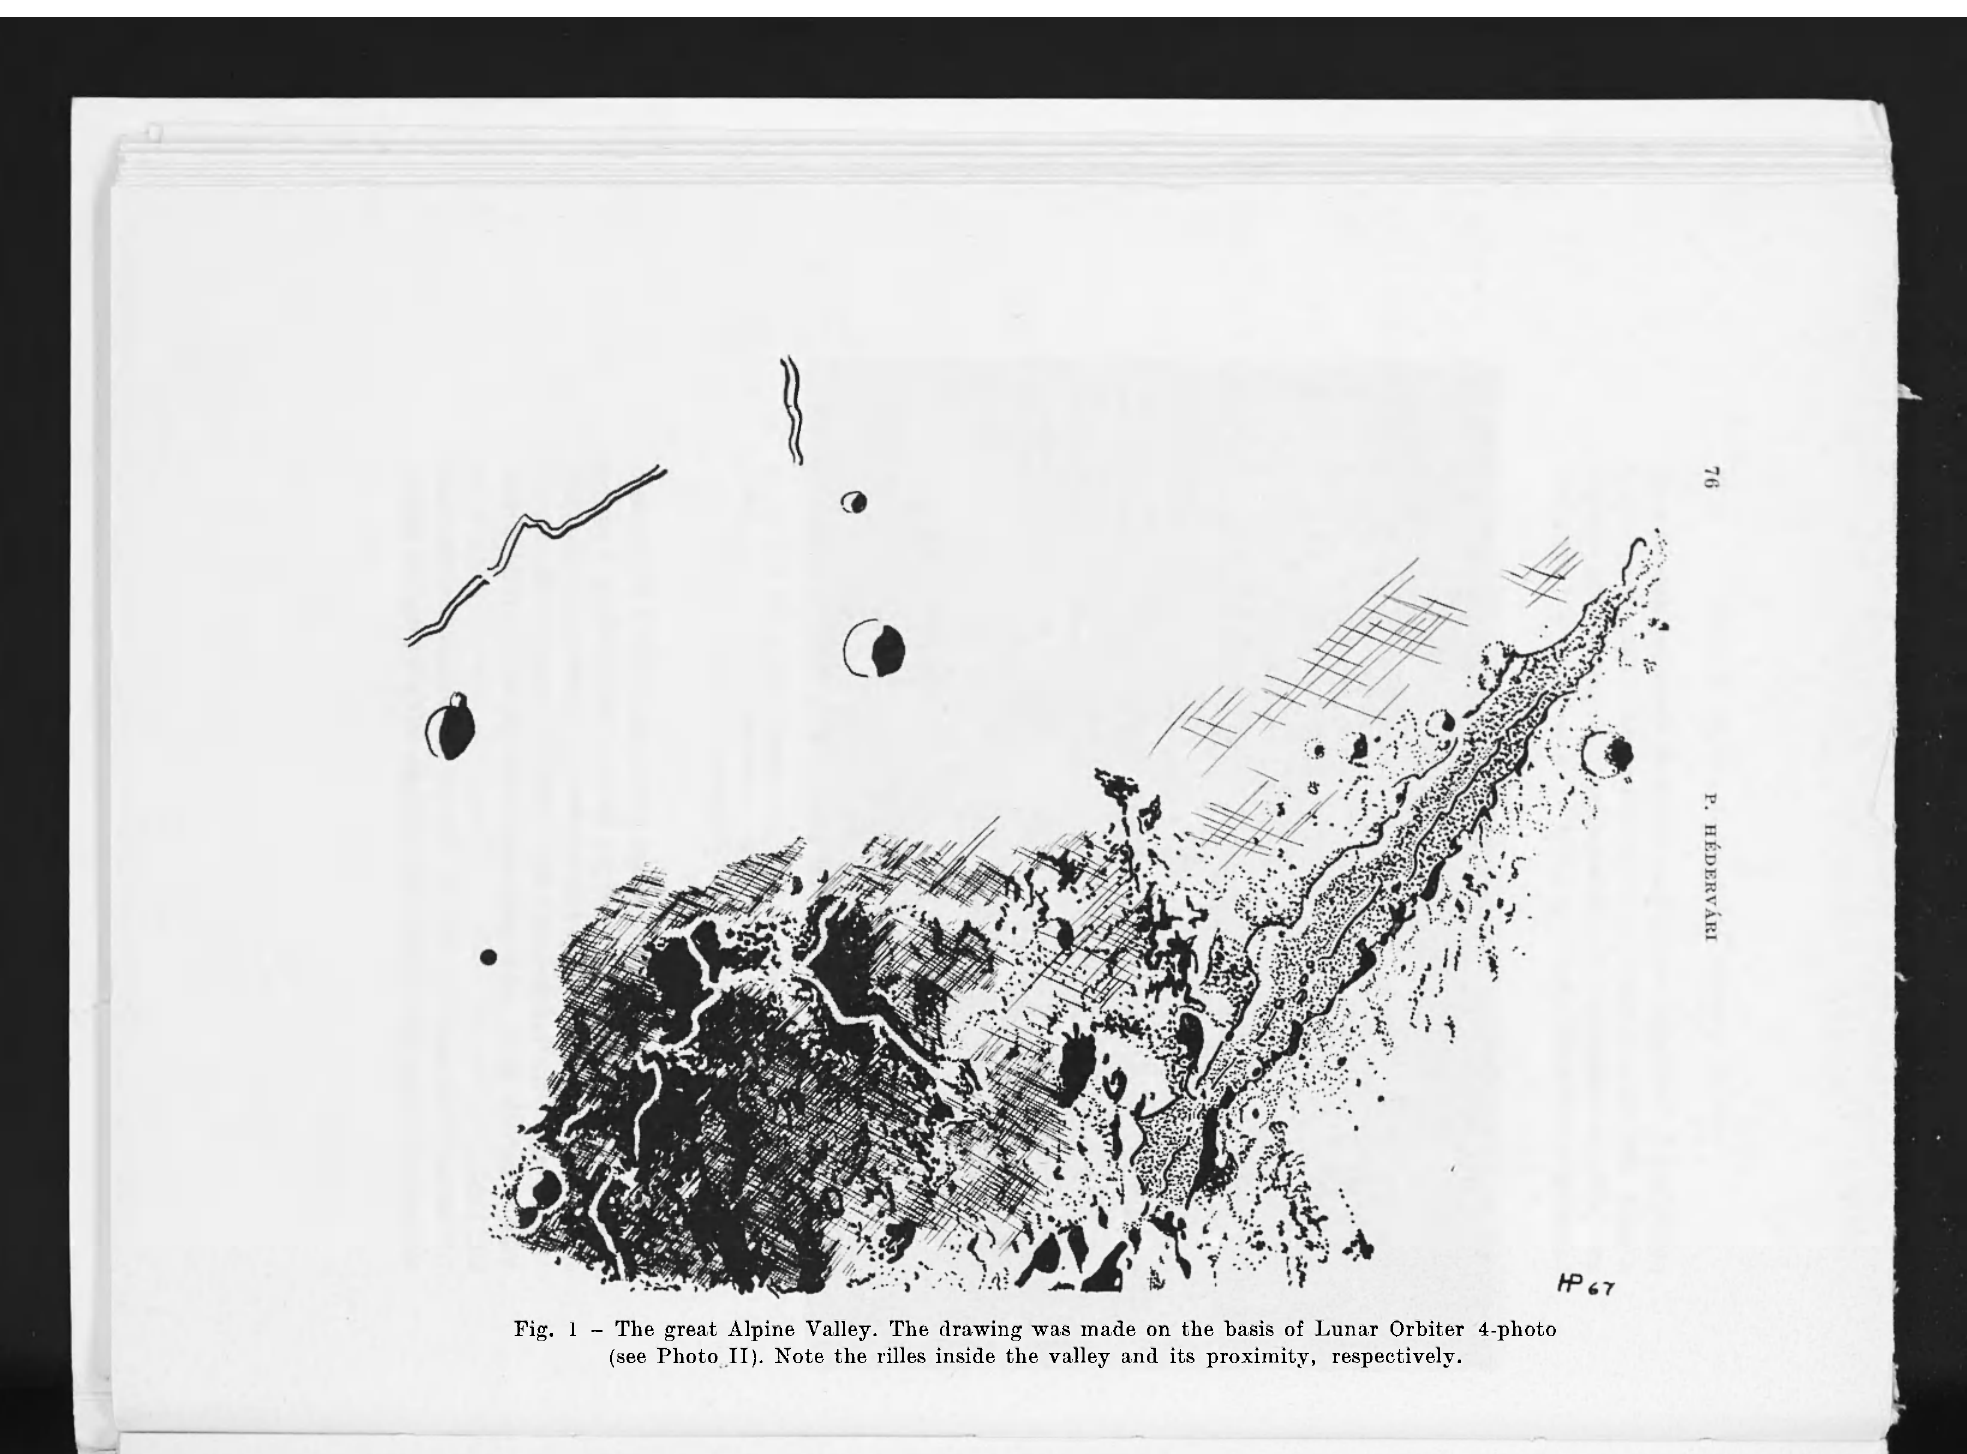
Fig. 1 - The great Alpine Valley. The drawing was made on the basis of Lunar Orbiter 4-photo (see Photo II). Note the rilles inside the valley and its proximity,